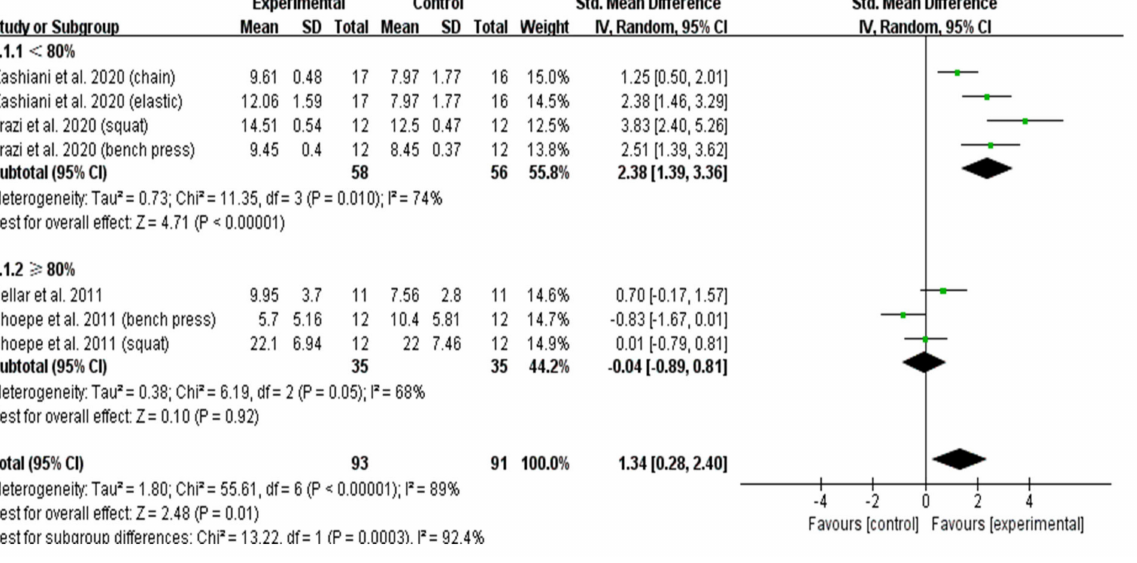
Figure 4. Forest plot of maximum-strength development: comparison between VRT and CRT after sensitivity analysis in untrained